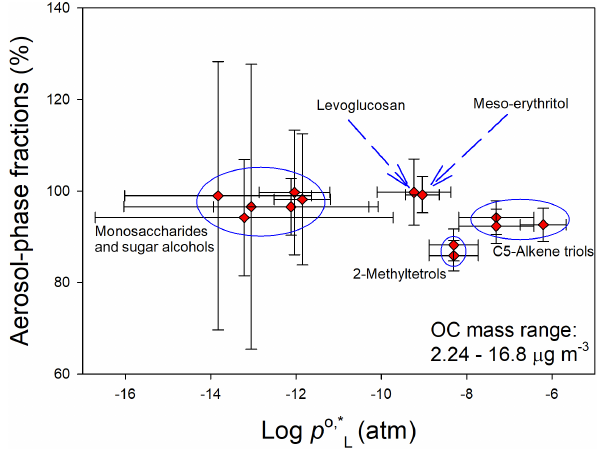
∗ Figure 3. Average particle-phase fractions and log p o , of indi- L vidual polyol tracers. Whiskers represent uncertainties of F % and ∗ 1 standard deviation of log p o , derived from different estimation L